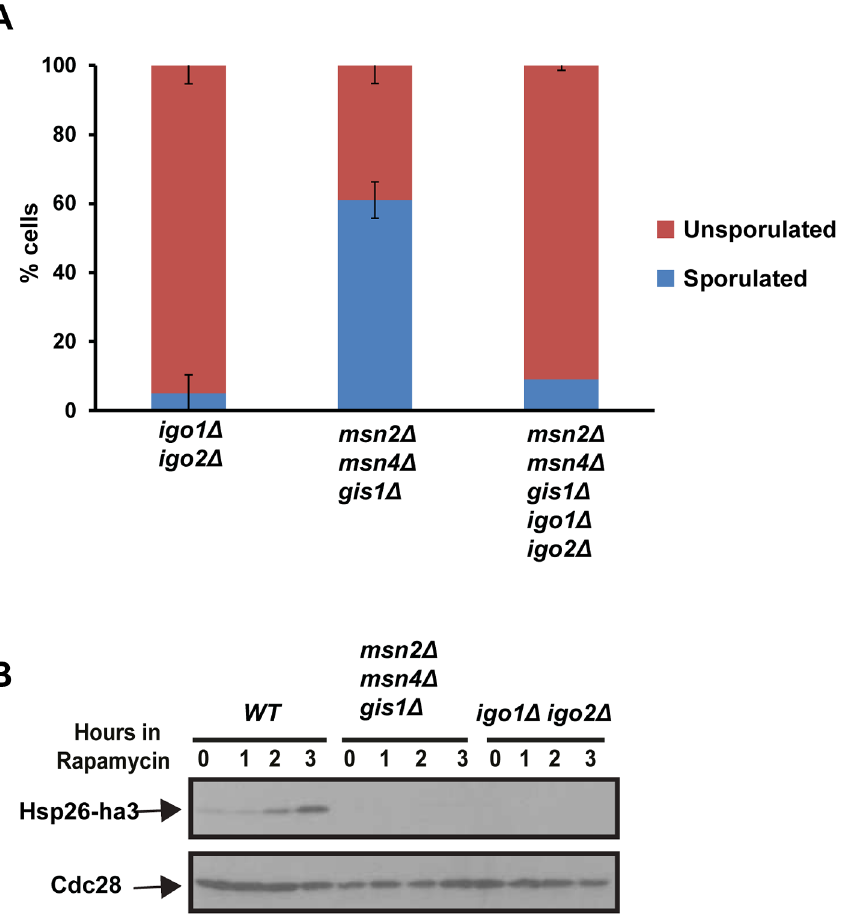
Figure 5. The G 0 -specific transcription factors Msn2, Msn4 and Gis1 are not required for entry into gametogenesis. A) igo1 D igo2 D , msn2 D msn4 D gis1 D , igo1 D igo2 D msn2 D msn4 D gis1 D mutant cells were incubated on sporulation plates for 24 hours and sporulation efficiency was measured (n=200). B) Wild type , igo1 D igo2 D and msn2 D msn4 D gis1 D cells carrying pRS316- HSP26 - ha3 plasmid were grown to log phase. Rapamycin (200 ng/ml) was added to the culture and total protein extract was prepared from cells at the indicated time points and Western analysis was performed using anti-HA and anti-Cdc28 antibodies.